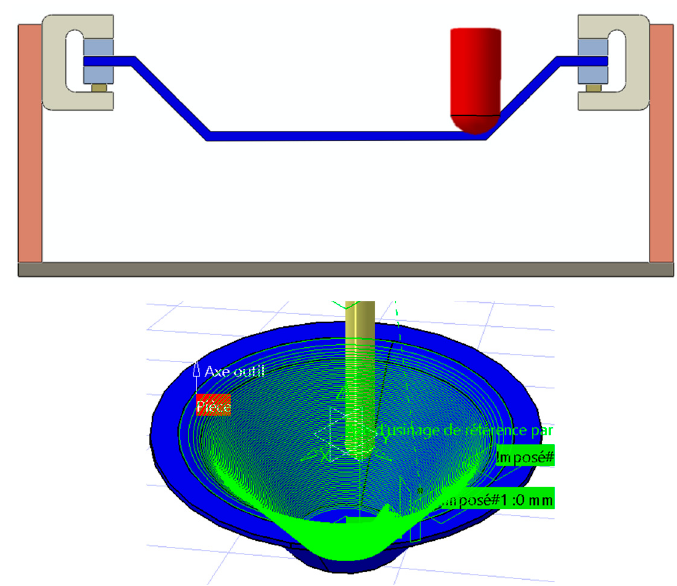
Figure 15. Schematic illustration of the SPIF principle.